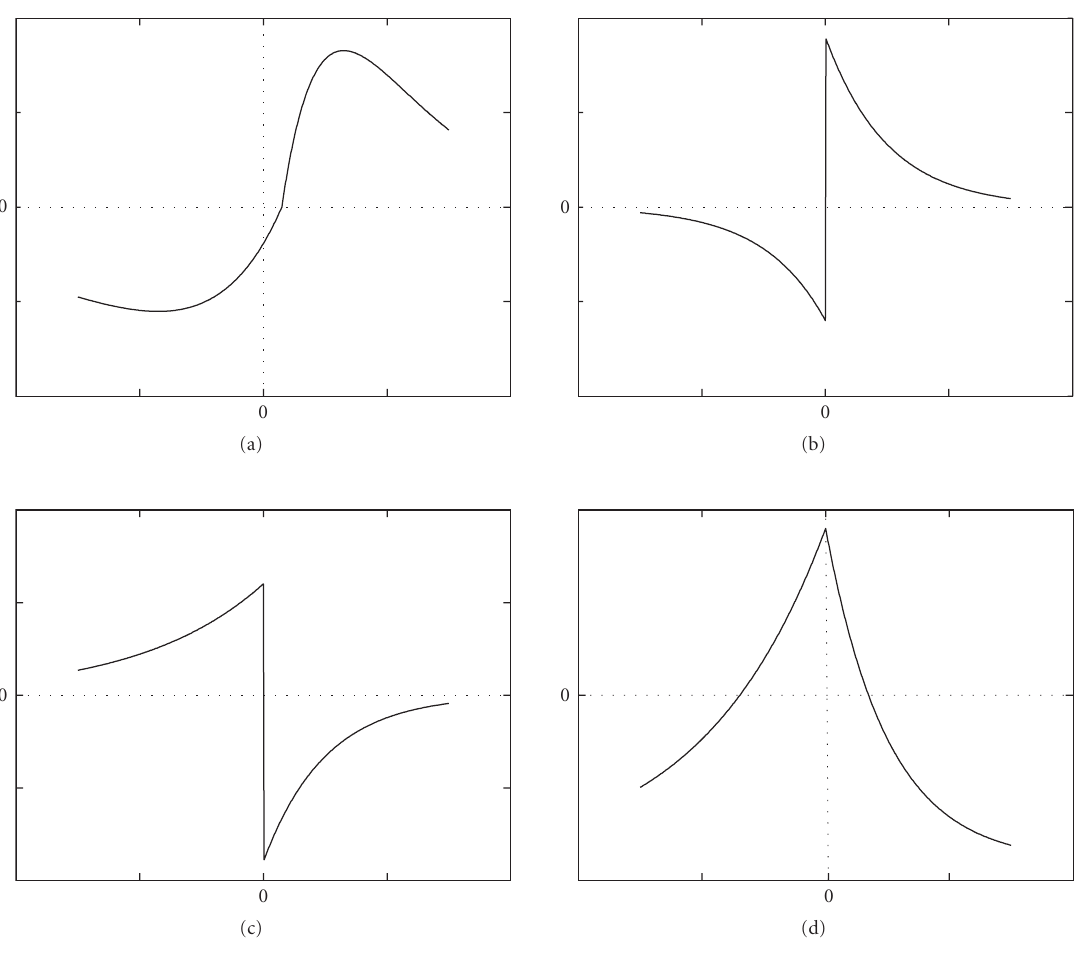
Figure 1: Di ff erent types of STDP curves are presented. (a) (c-STDP ) (b) discontinuous STDP(dc-STDP); (c) discontinuous anti-STDP(dc- aSTDP); (d) inhibitory